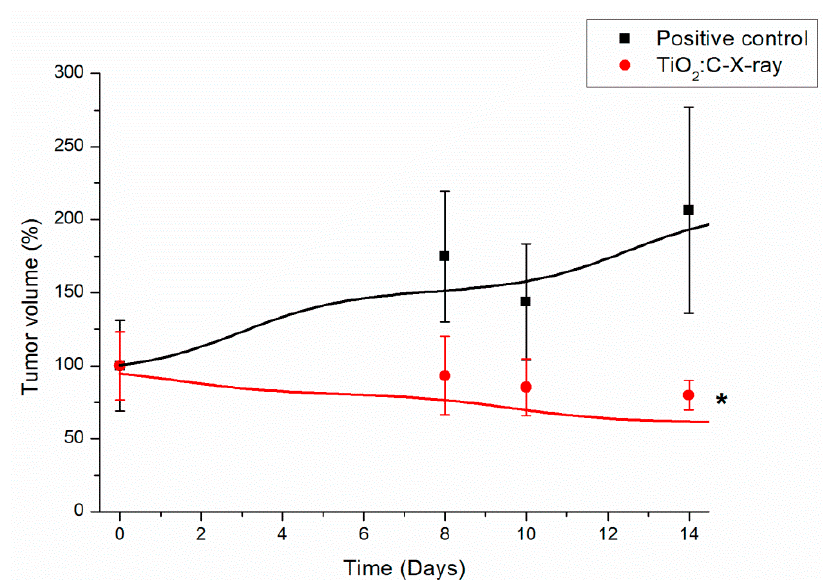
Figure 6. Tumor size in BALB/c nude mice injected with TiO 2 :C and subjected to X-ray irradiation ( t - test, mean ± SD, n = 4, *: p -value < 0.05).